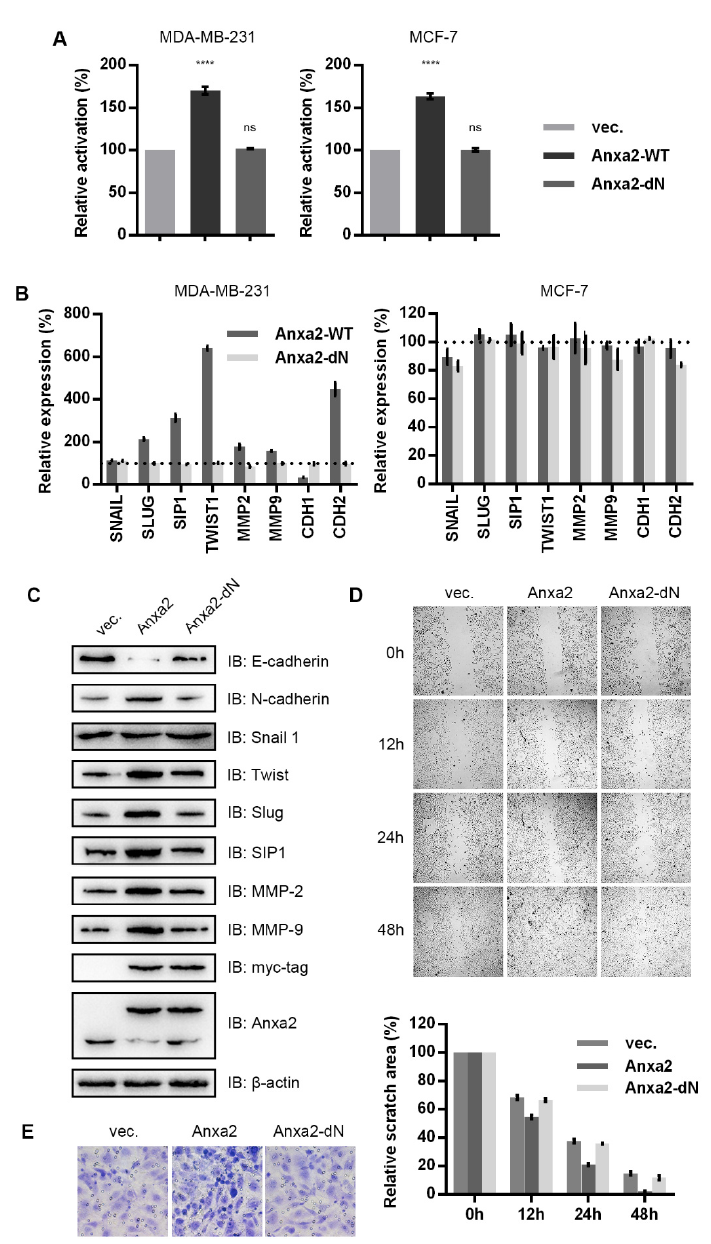
Figure 2. Anxa2 over-expression enhanced NF- κ B activation and related cell migration and invasion. ( A ) NF- κ B activity was determined via a dual luciferase reporter assay in MDA-MB-231 cells and MCF-7 cells transfected with empty vector, Anxa2 and Anxa2-dN. ( B ) mRNA levels of indicated genes were determined by RT-PCR with RNA extract from MDA-MB-231 cells and MCF-7 cells transfected with Anxa2 and Anxa2-dN t, the dot line at 100% presents mRNA levels in cells transfected with empty vector. ( C ) The protein levels of indicated genes were determined by immuno-blot in MDA-MB-231 cells transfected with empty vector (vec.), Anxa2 and Anxa2-dN. A total of 30 µ g of whole-cell protein extract was loaded for immuno-blotting assay. ( D ) A wound healing assay was performed with MDA-MB-231 cells transfected with empty vector (vec.), Anxa2 and Anxa2-dN. Relative scratch area was shown below the microscopy images. ( E ) A Transwell invasion assay was performed with MDA-MB-231 cells transfected with empty vector (vec.), Anxa2 and Anxa2-dN. All experiments were repeated for three times and all data are shown as mean ± SD, with **** presenting p < 0.0001, *** presenting p < 0.001, ** p < 0.01, * presenting p < 0.05 and ns presenting p >